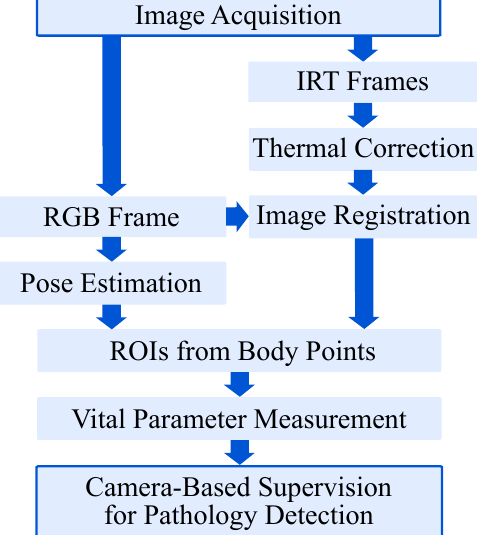
Figure 5. Overview of the pathology detection algorithm. Multithreading was used for parallel data processing.